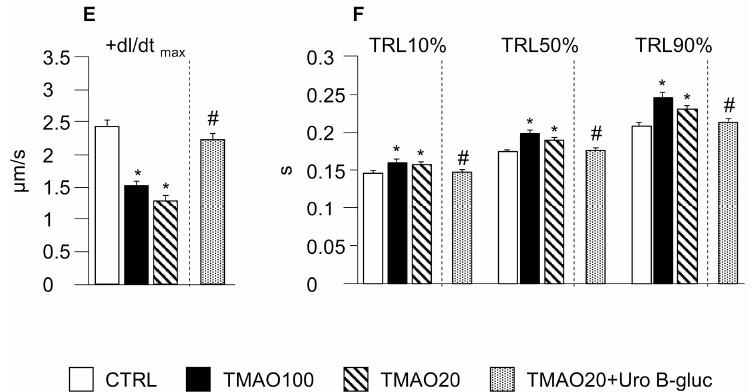
Figure 1. Cell mechanics. Representative examples of sarcomere shortening (SL) ( A ) recorded from CTRL, TMAO100, TMAO20 and TMAO20 + Uro B-gluc ventricular myocytes. In bar graphs ( B – F ): mean values ± SEM of diastolic sarcomere length (SL; B ), maximal rate of shortening ( − dl/dt max ; C ), fraction of shortening (FS; D ), maximal rate of re-lengthening (+dl/dt max ; E ), time at 10%, 50%, and 90% of re-lengthening (TRL10%, TRL50%, TRL90%; F ), measured in CTRL (n = 115), TMAO100 ( n = 84), TMAO20 ( n = 100), and TMAO20 + Uro B-gluc ( n = 82) cells. * p < 0.05 significant differences vs. CTRL; # p < 0.05 significant differences vs. TMAO20. General Linear Model/ANOVA GLM/ANOVA for repeated measurements was used first to compare CTRL, TMAO100, and TMAO20 groups to evaluate TMAO dose-dependent effects, and then CTRL, TMAO20, and TMAO20 + Uro B-gluc groups, after selecting the TMAO minimal effective dose.